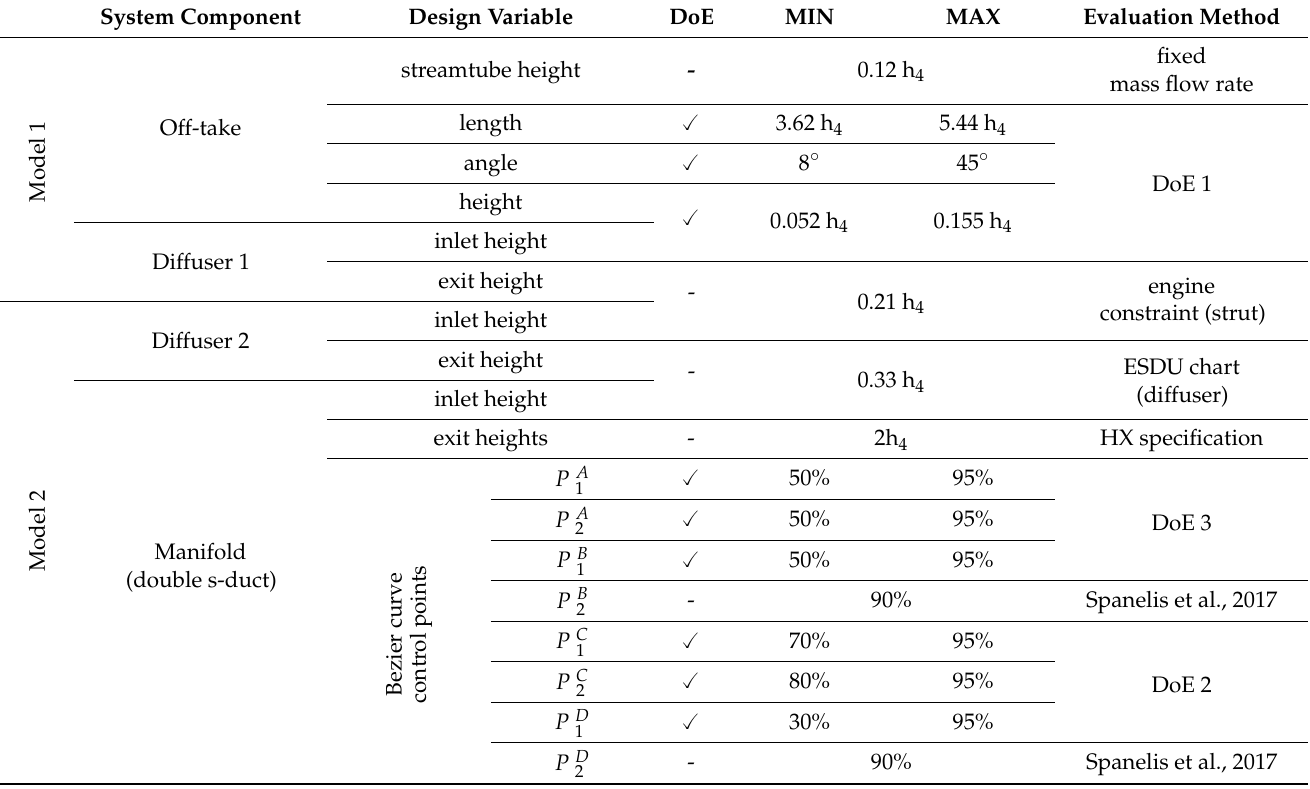
Table 2. Complete parametric model summary and factorial design